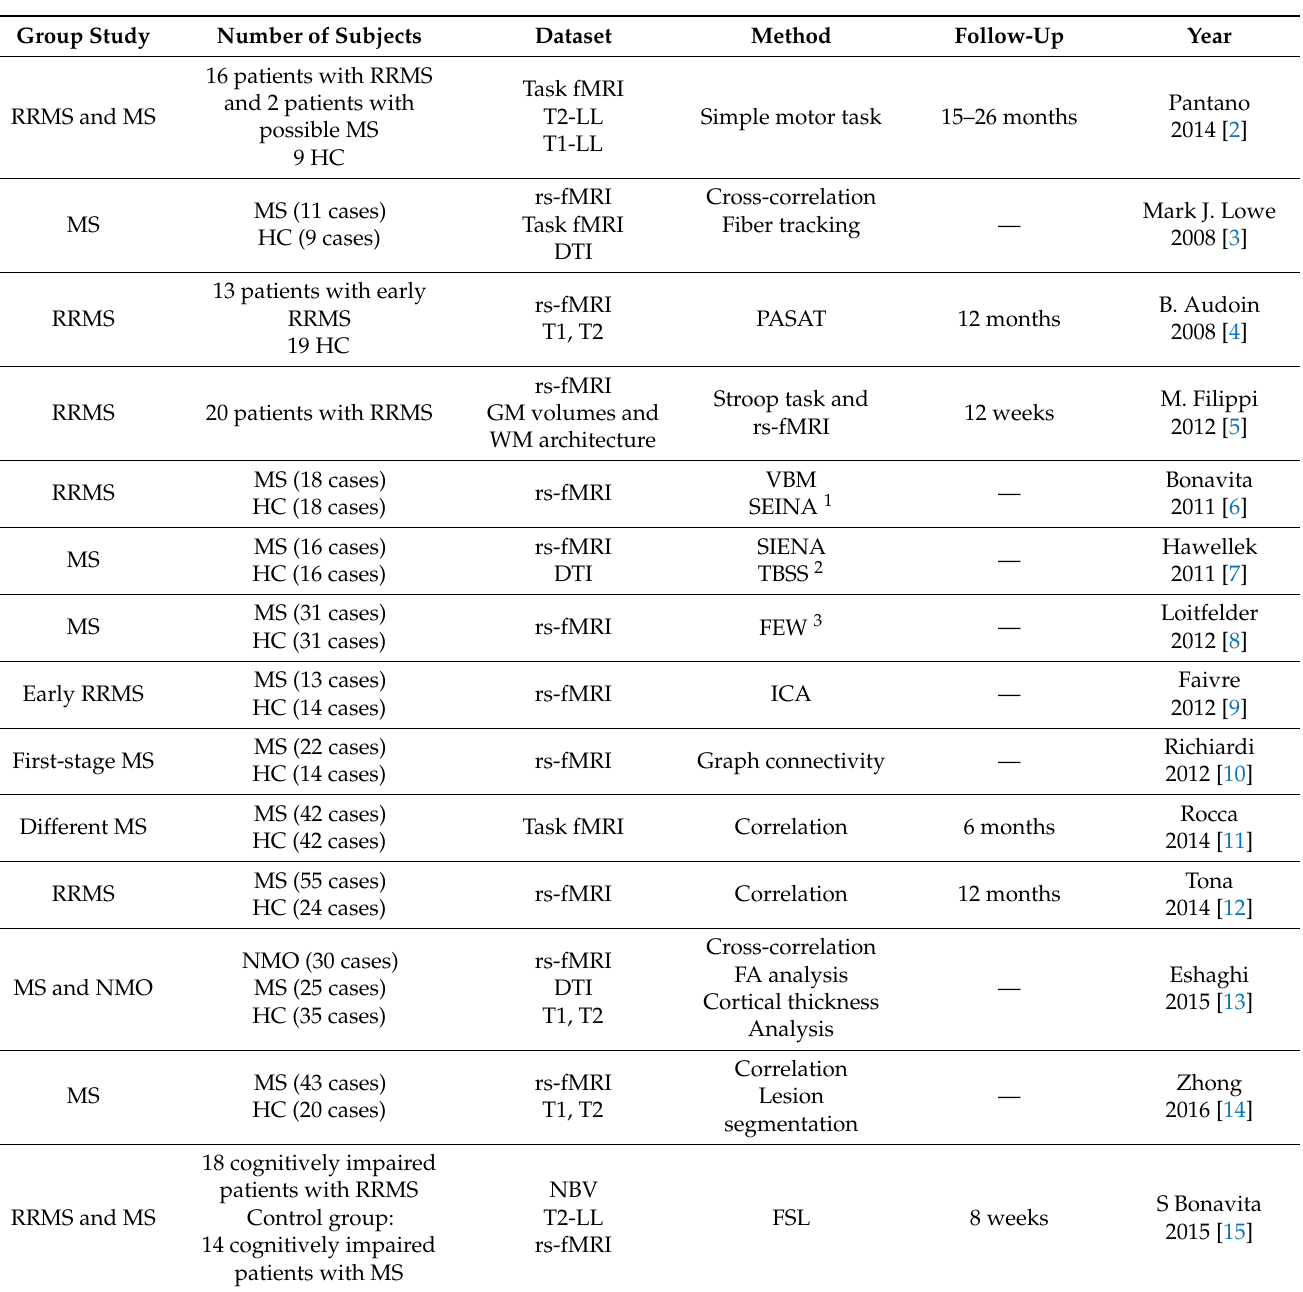
Table 1. Studies on MS using fMRI and other MRI